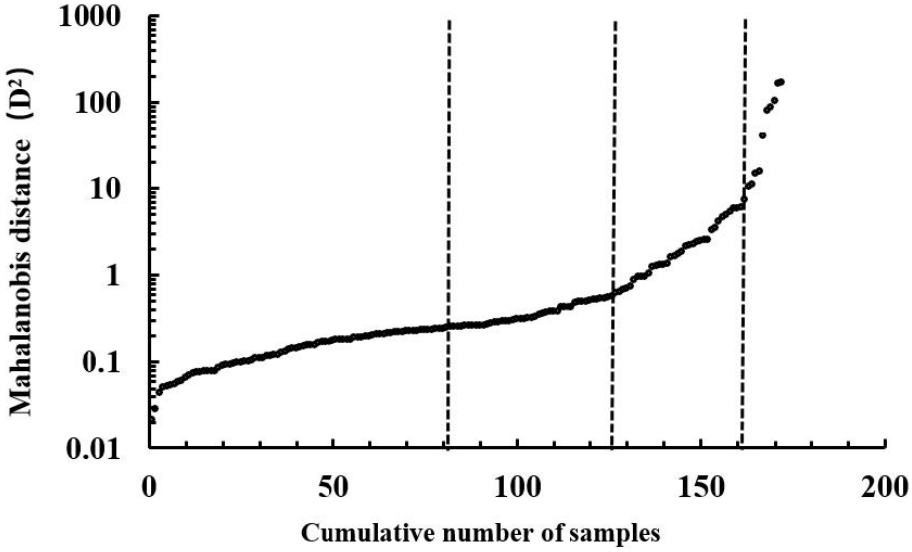
Figure 4. Mahalanobis distances of contrast coefficients of groundwater samples in 2019.